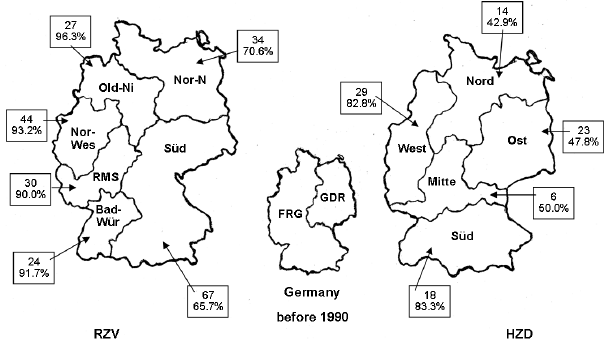
Figure 1. Number of breeding bitches and frequencies of the Ho2 haplotype in the branches (“ landesgruppen ”) of the two Ger- man kennel organization: RZV and HZD. Abbreviations: